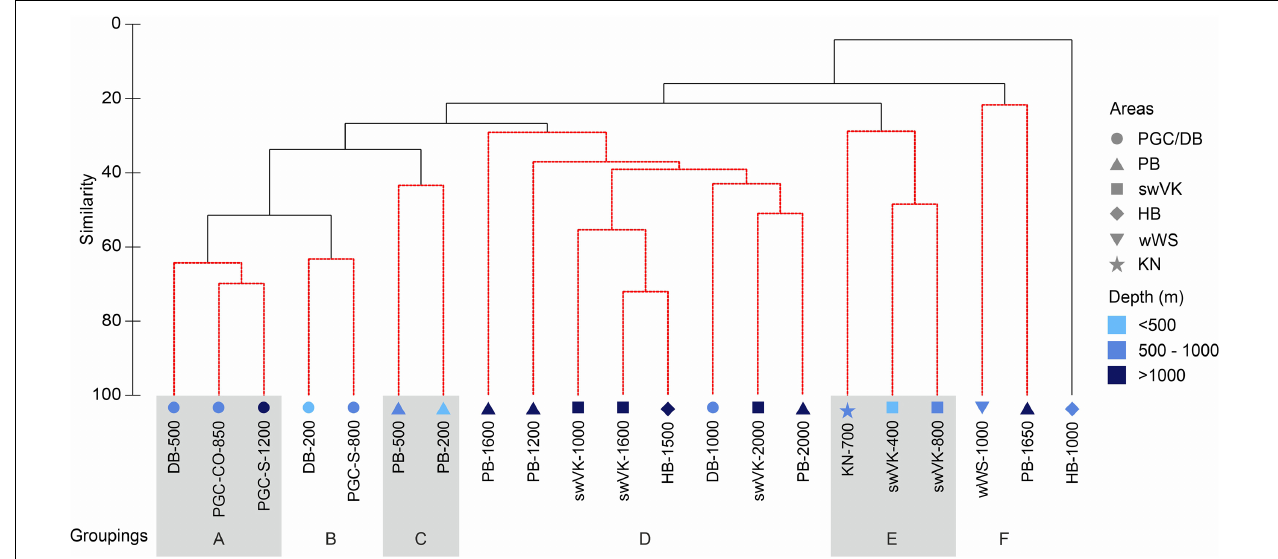
FIGURE 6 | Weddell Gyre region similarity species cluster analysis by station. DB, Duse Bay; PGC, Prince Gustav Channel; PB, Powell Basin; swVK, southwest of Vestkapp; HB, Halley Bay; wWS, western Weddell Sea; KN, Kap Norvegia; DB, Duse Bay; PGC, Prince Gustav Channel; S, South; CO, Cape Obelisk. Fourth root transformation and Bray Curtis similarity of resemblance. SIMPROF groupings in red.